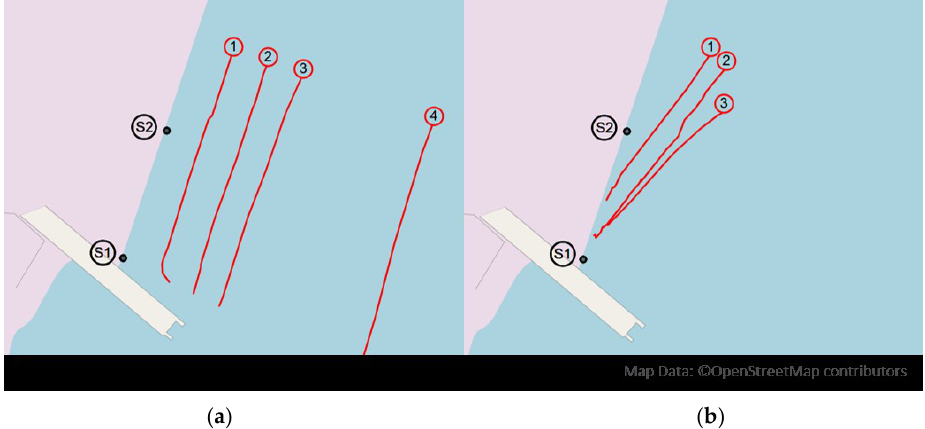
Figure 11. Test campaign scenarios ( a ) parallel sailing (scenarios 1.1–1.4), ( b ) berthing maneuvers (scenarios 2.1–2.3).